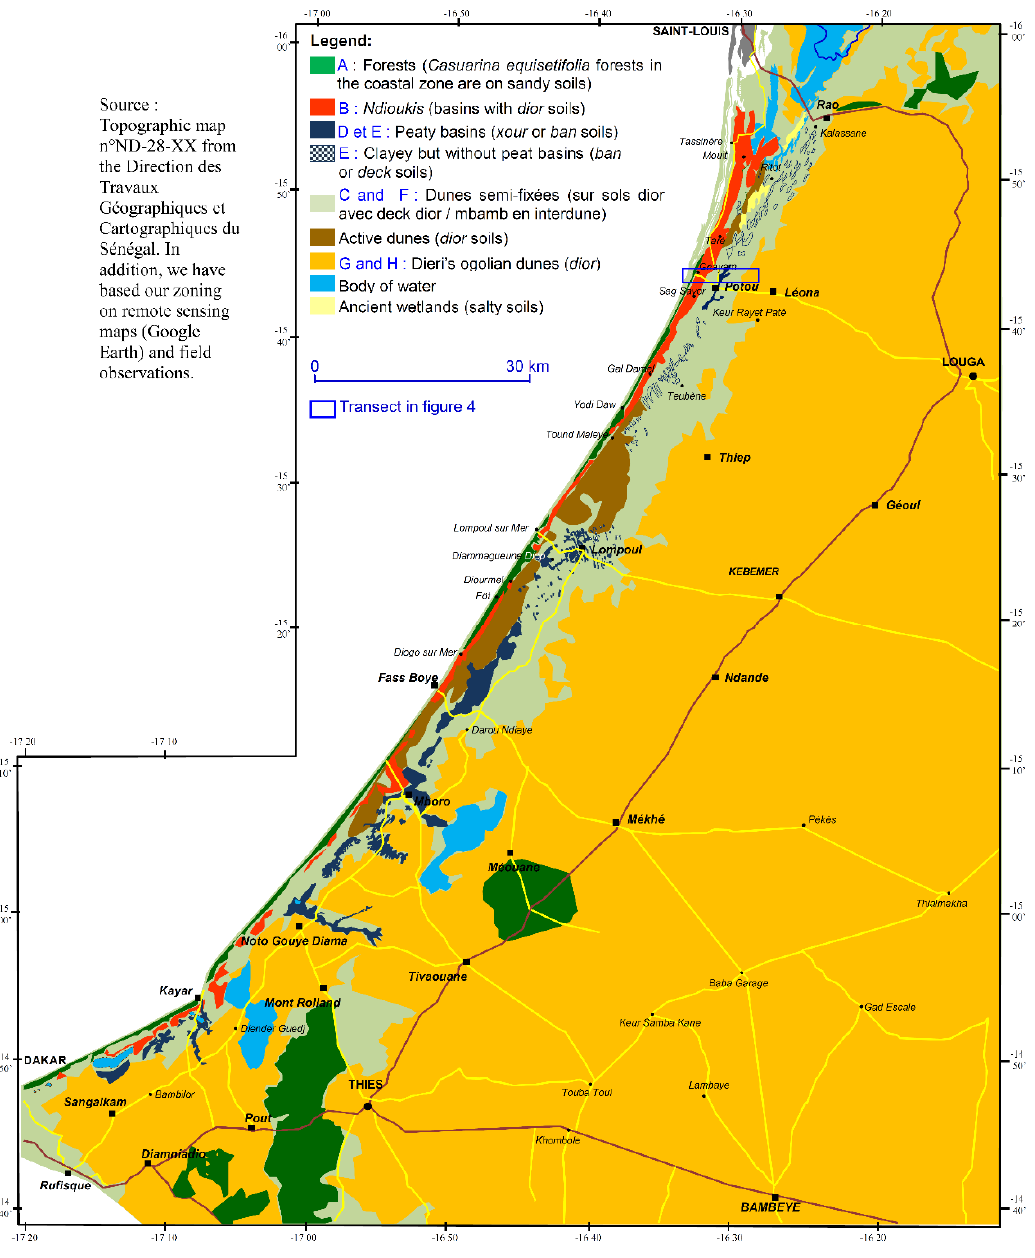
Figure 3. Zoning of the survey region.